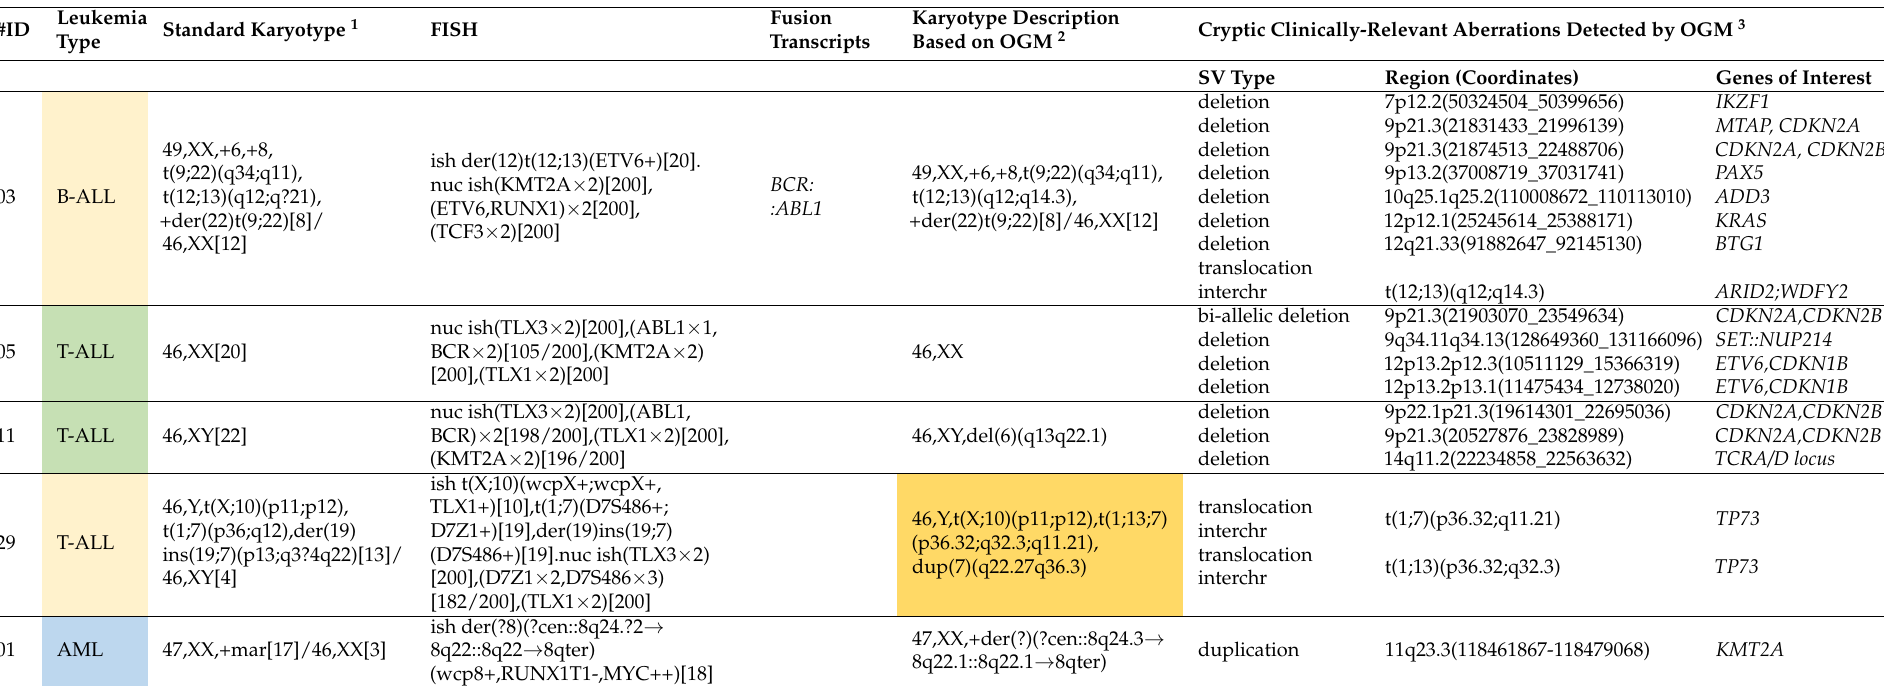
Table 3. Detailed results of standard testing and OGM for 5 cases with additional information provided by